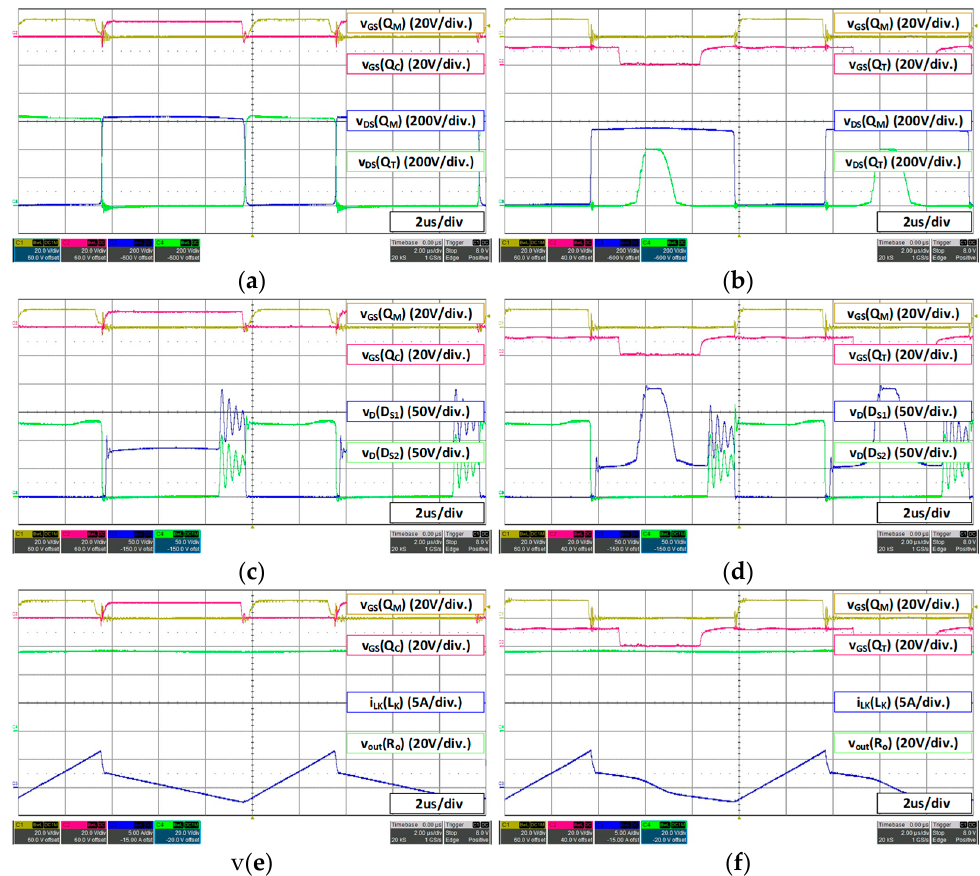
Figure 15. 48 V battery (56 V 4.5 A) load waveform: ( a ) conventional converter MOSFET voltage stress; ( b ) proposed converter MOSFET voltage stress; ( c ) conventional converter secondary rectifier voltage stress; ( d ) proposed converter secondary rectifier voltage stress; ( e ) conventional converter V out ; ( f ) proposed converter V out .